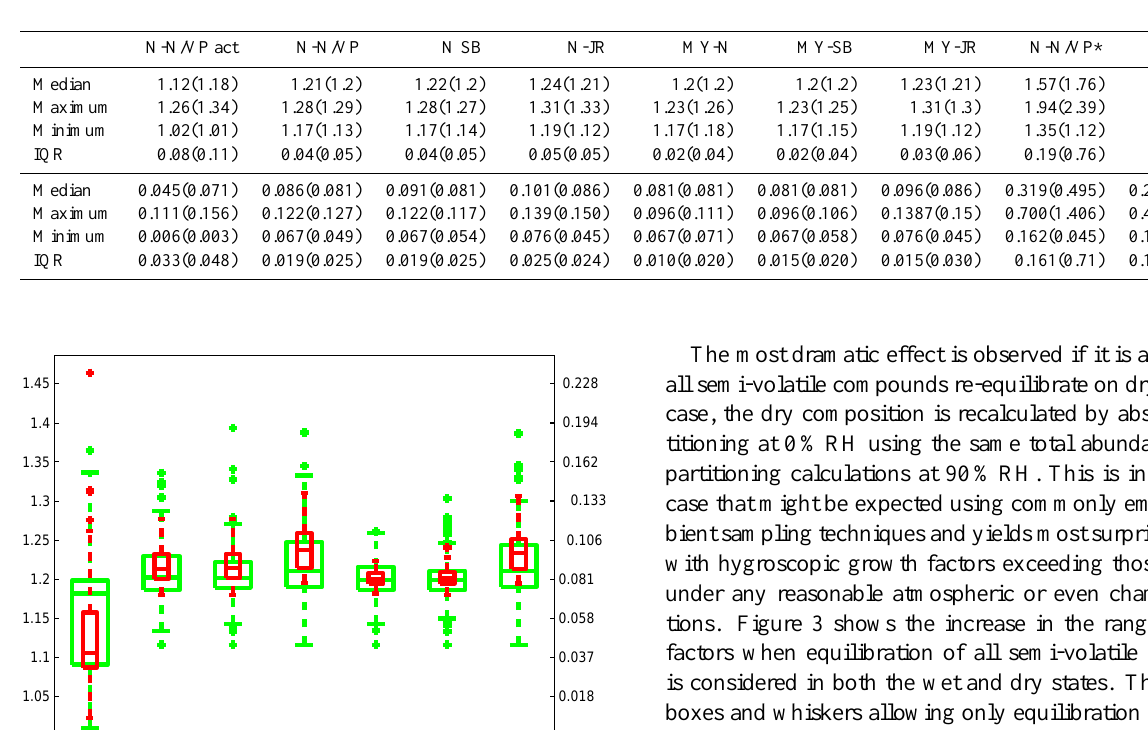
Table 2. Predicted hygroscopicity across all simulations. The first four rows present the hygroscopic diameter growth factor, GF D variability with predictive technique, complexity and assumptions of equilibration on particle drying. The bottom four rows present the corresponding single parameter hygroscopicity κ -values. * Denotes an assumption of re-equilibration of all semi-volatiles on drying within the HTDMA (option “b”) in Fig. 1. 10000 compound testcases outside brackets, 2 compound testcases in brackets.